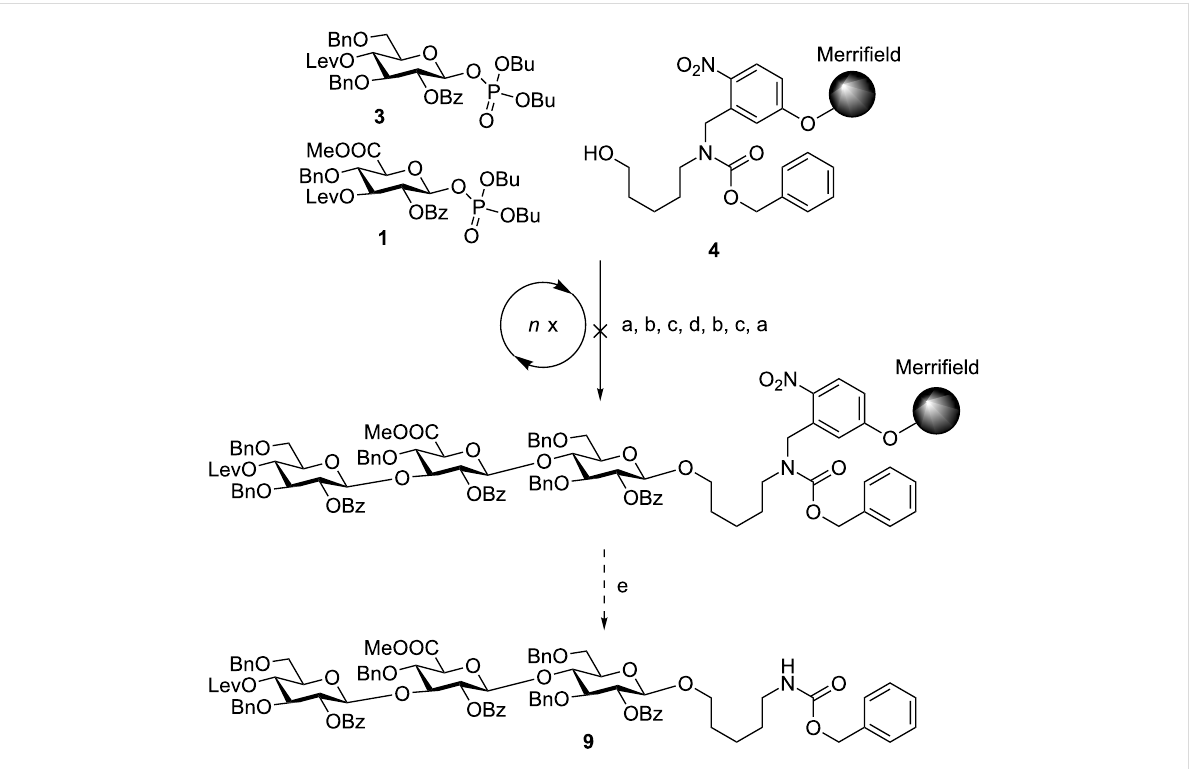
Scheme 2: Attempted AGA of SP3 trisaccharide 9 using glycosyl phosphate building blocks 1 and 3 . Reagents and conditions: a) 3 (3 equiv), TMSOTf, CH